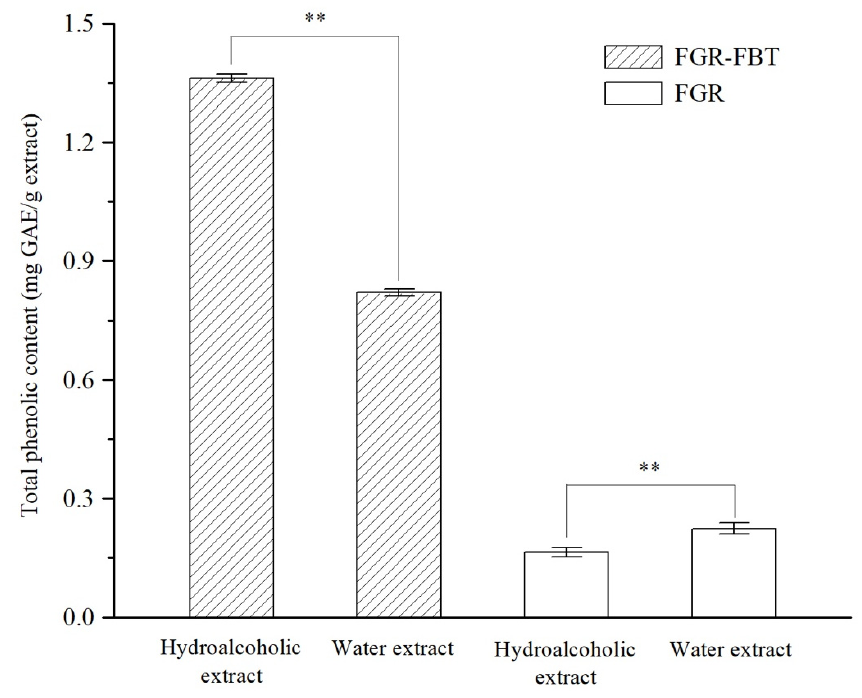
Figure 2. The total phenolic contents of hydroalcoholic extracts (80% ethanol extracts) and water extracts of fermented glutinous rice with Fu brick tea (FGR-FBT) and traditional fermented glutinous rice (FGR). ** shows significant differences between samples ( P < 0.01).